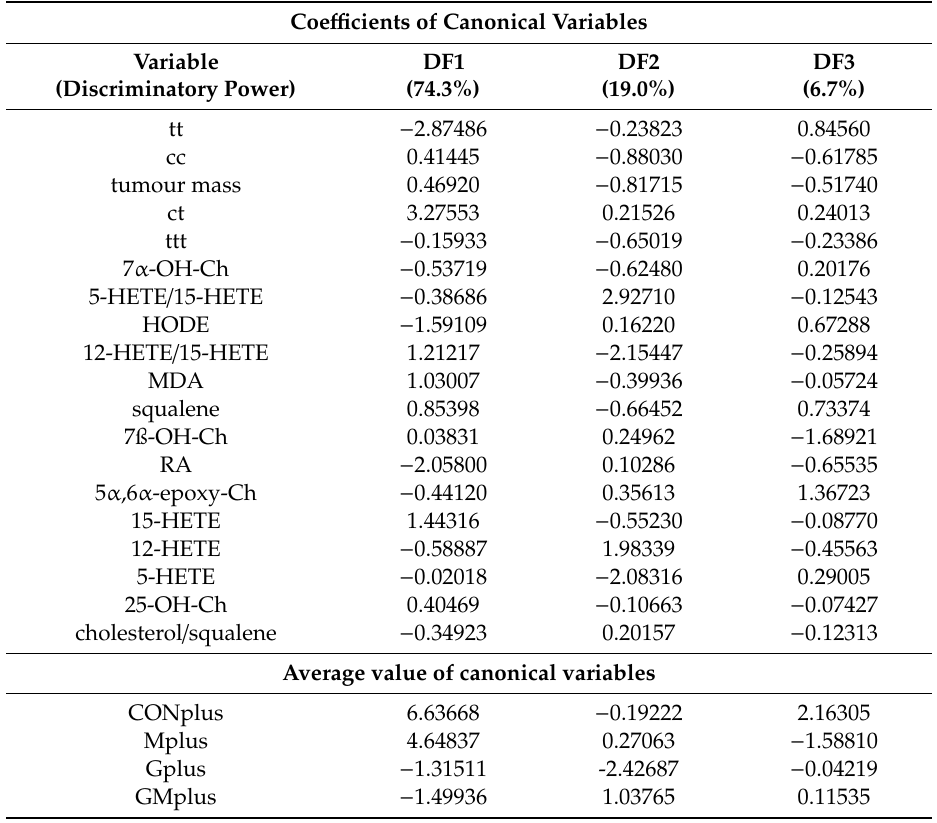
Table A2. Coe ffi cients and average value of canonical variables included in the final